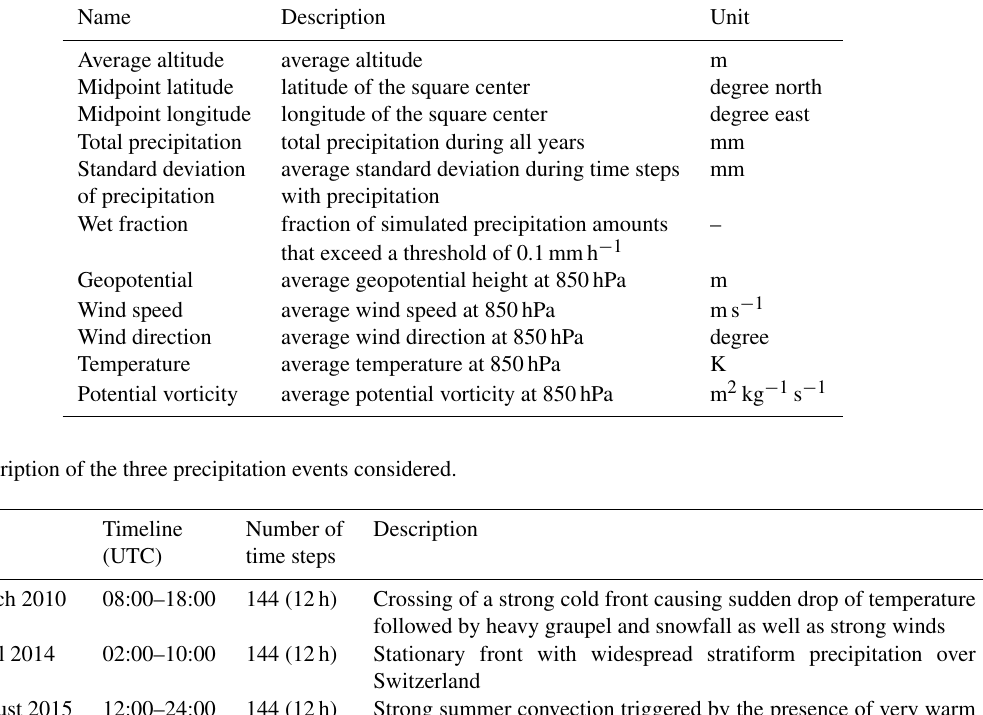
Table 1. List and description of all meteorological and topographical descriptors used in the MF characterization of the climatology of precipitation intensities.